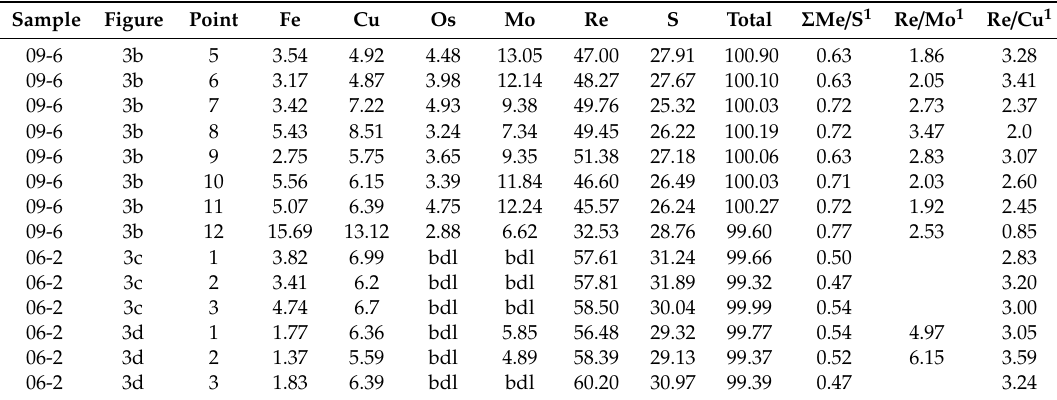
Table 2. Electron-microprobe analyses (wt. %) of the Re